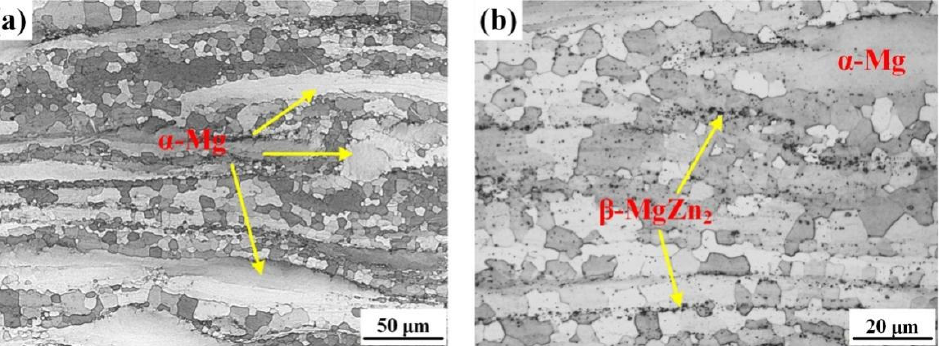
Figure 5. The microstructure of ZK60 extrusion alloy at ( a ) low magnification and ( b ) high magnification.